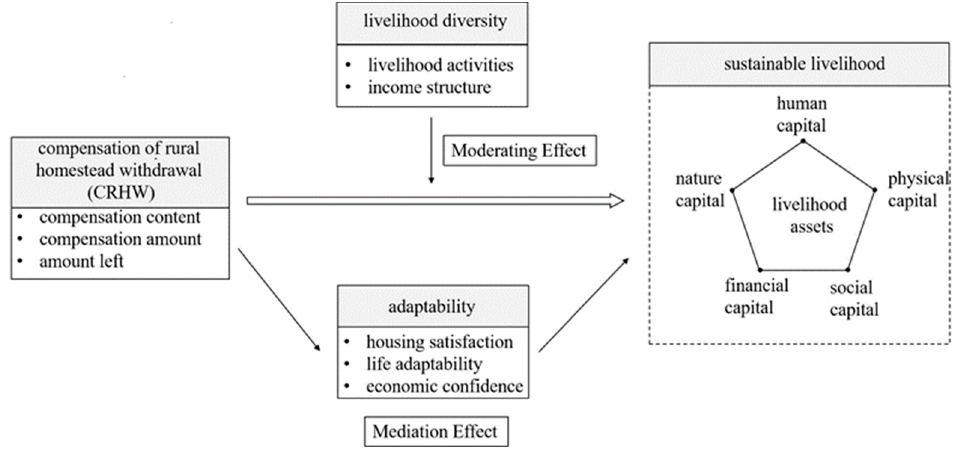
Figure 1. Analysis framework of the impact mechanisms of the CRHW, livelihood diversity, and adaptation on sustainable livelihoods.